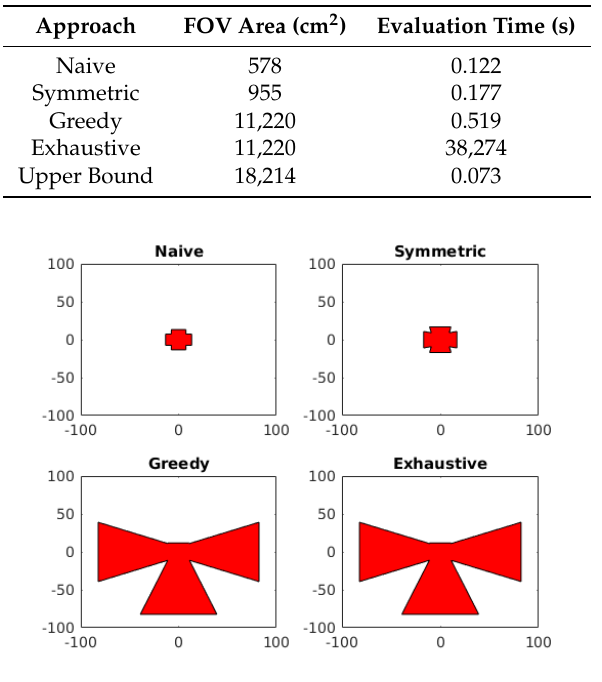
Figure 9. The resulting views of the four approaches applied to the restrictions of the trocar camera